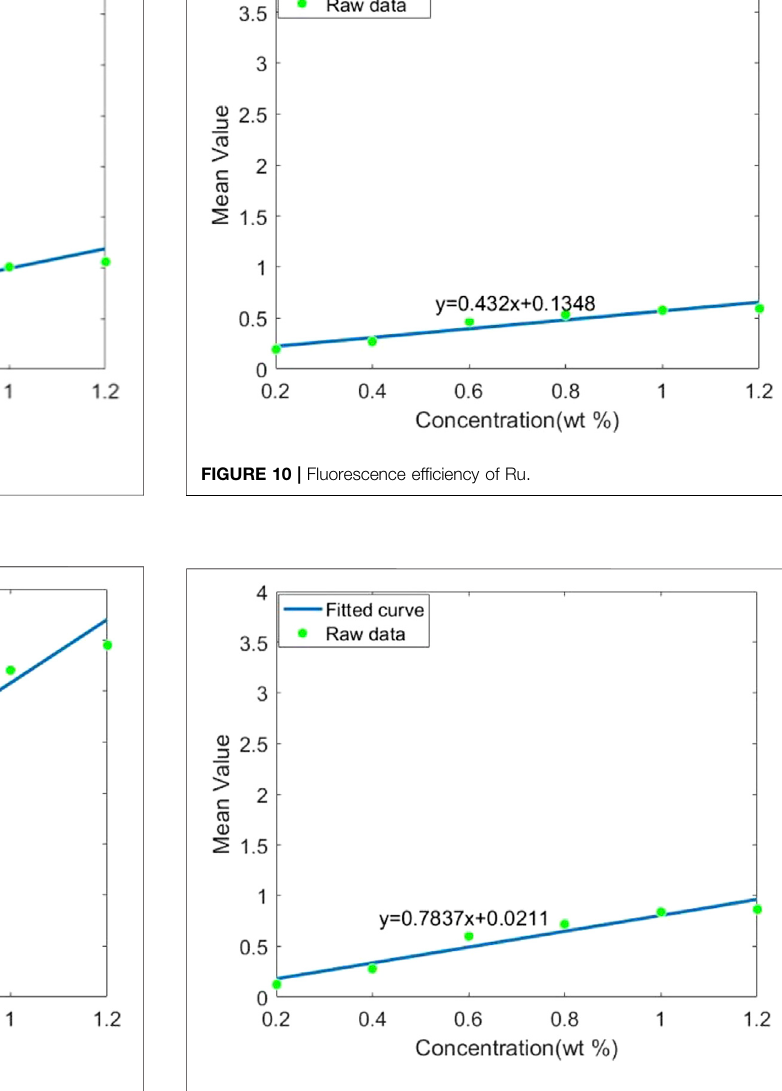
FIGURE 11 | Fluorescence efficiency of